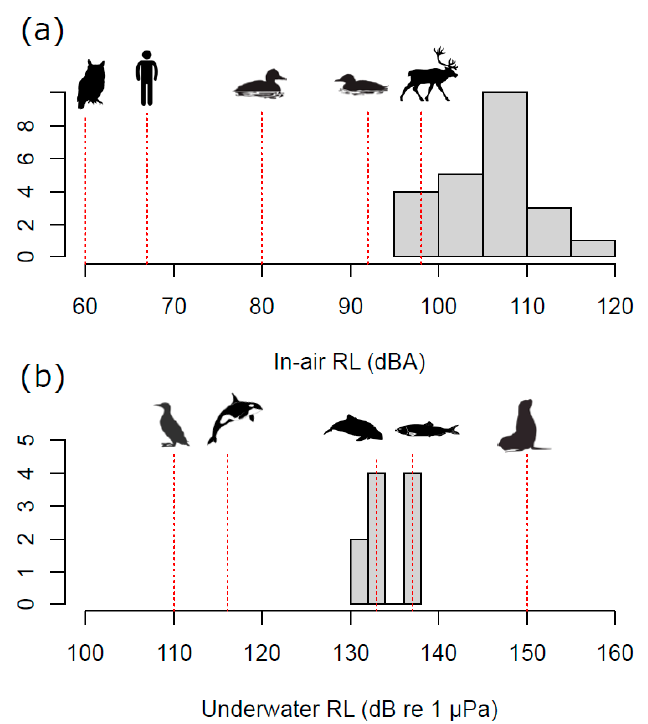
Figure 5. The distribution of received levels (RL) for ( a ) 23 in-air overflight events and ( b ) 10 flight events recorded under water relative to thresholds known to cause behavioral and physiological responses in humans and representative suites of terrestrial and marine wildlife. In-air: owls, 60 dBA = physiological stress responses [31], 50% chance of nest flushing [32], and 50% reduction in the probability of prey detection and hunting strikes [33]; humans, 67 dBA = 50% probability of awakening at night [29] and increases in nighttime blood pressure [28]; harlequin duck, 80 dBA = reduced courtship and increased vigilance and agonism [34]; marbled murrelet, 92 dBA = risk of disturbance in nesting marbled murrelets [30]; caribou, 98 ASEL (A-weighted sound exposure level) = interrupted resting bouts and increased activity [35]. (Note: The threshold for caribou was reported in ASEL which likely overestimates RL (dBA).) Underwater: common murre, 110 dB re 1 µPa = startle response and interrupted feeding [37]; killer whales, 116 dB re 1 µPa = evading noise from small boats [36]; harbor porpoise, 133 dB re 1 µPa = 50% probability of startle response to low- and mid-frequency up/downsweeps [38]; herring, 137 dB re 1 µPa = startle response to recorded boat noise [39]; California sea lions, 150 dB re 1 µPa = 50% probability of avoidance of area with a simulated mid-frequency tactical sonar signal [40].